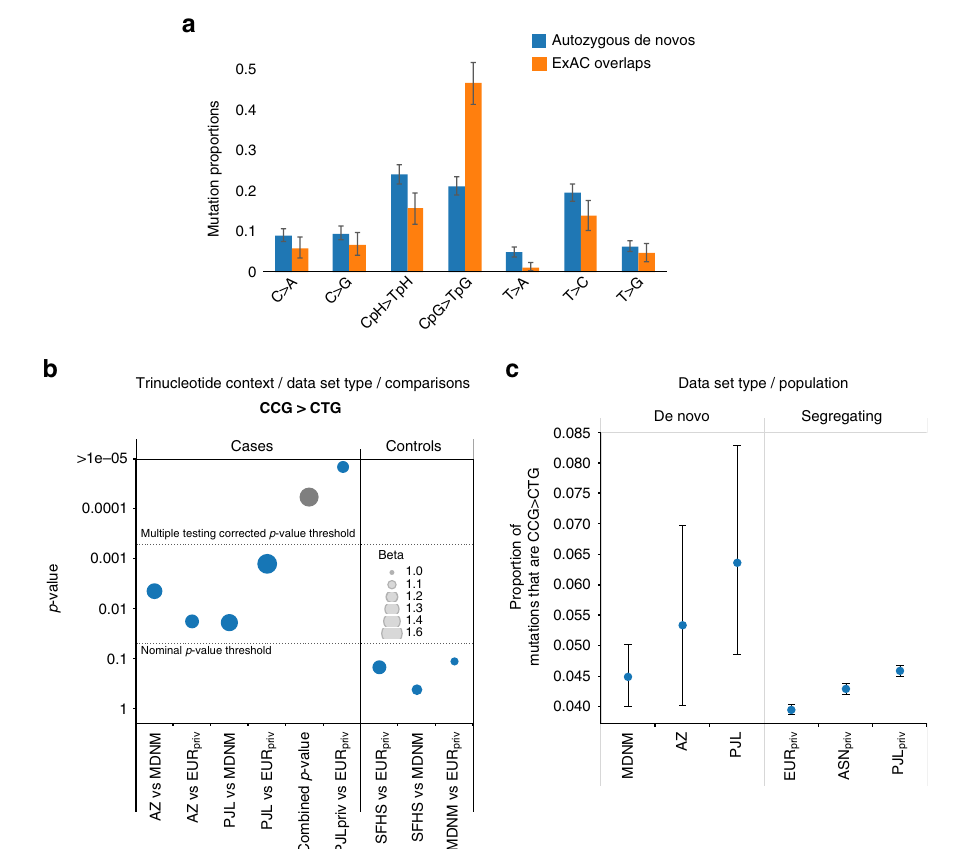
Fig. 3 Signatures of DNMs and overlap of mutations with ExAC. a The distribution of de novo mutational signatures across all 1152 singleton candidate de novo mutations and 350 that overlap with ExAC. b Differences in context-speci fi c mutation rate. y -axis: signi fi cance of the difference in proportion of 5 ʹ CCG → CTG 3 ʹ DNMs in 1152 mutations from the autozygosity data set (AZ) and 850 DNMs from the 1000 Genomes Project Complete Genomics trio data set (PJL) in comparison with 6948 mutations from the meta-analysis data set ( MDNM ) and variants private to Europeans in the 1000 Genomes Project (EURpriv). The combined p -value shows the result of meta-analysis of the AZ/MDNM and PJL/EURpriv comparisons. A comparison between private mutations in PJL and EUR in the 1000 Genomes Project population data set (PJLpriv) and (EURpriv), respectively is also shown. Signi fi cance of the difference in 747 DNMs from the Scottish Family Health Study ( SFHS ) is shown as a control; the size of the disk indicates the fold difference of the test as in the legend. c Proportion of mutations that are 5 ʹ CCG → CTG 3 ʹ for various whole genome data sets. The AZ data were adjusted for trinucleotide composition differences between exomes and whole genomes. PJLpriv variants show this increased context-speci fi c mutation rate compared to both East Asians (ASNpriv) and Europeans (EURpriv) indicating that the increase is speci fi c to